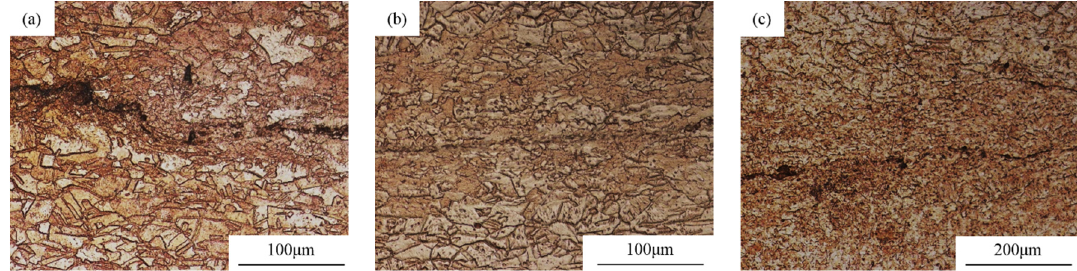
Figure 9. Metallographic diagram of the joints with different welding forces: ( a ) 600 N; ( b ) 1200 N; ( c ) 1400 N.